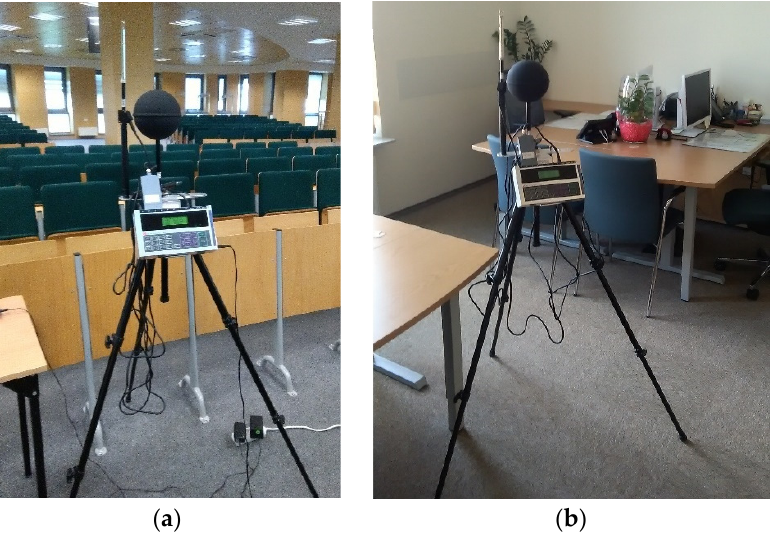
Figure 3. The measuring station in the lecture room of “Energis” ( a ); and the office room in the Courthouse ( b